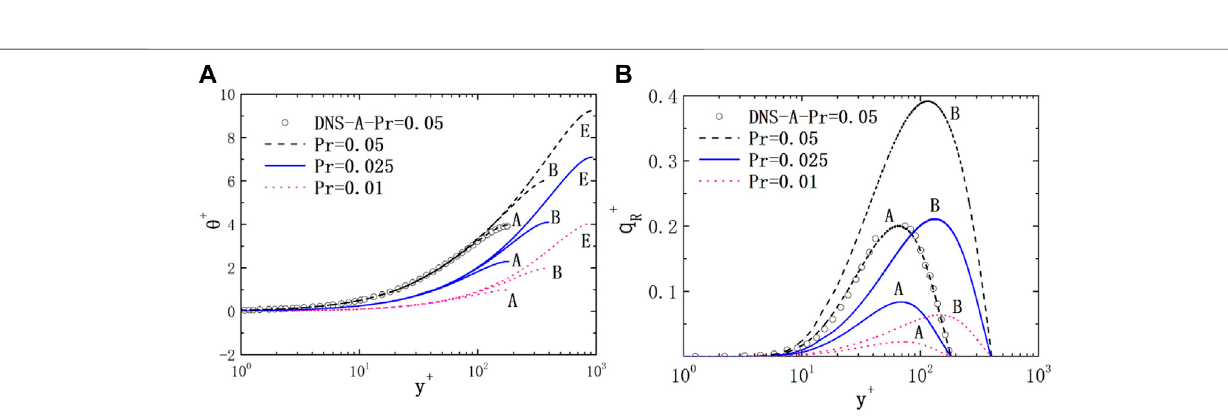
FIGURE 5 | Non-dimensional temperature and heat fl ux of the plane for different Pr fl uids. (A) temperature; (B) heat fl ux.